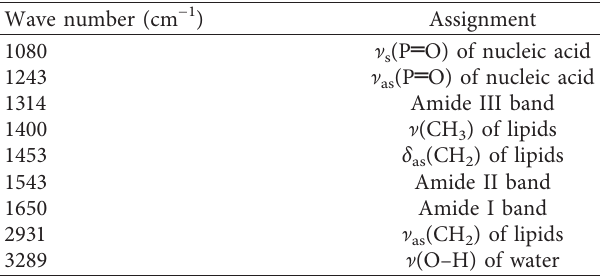
Table 4: The main IR absorption bands and their corresponding